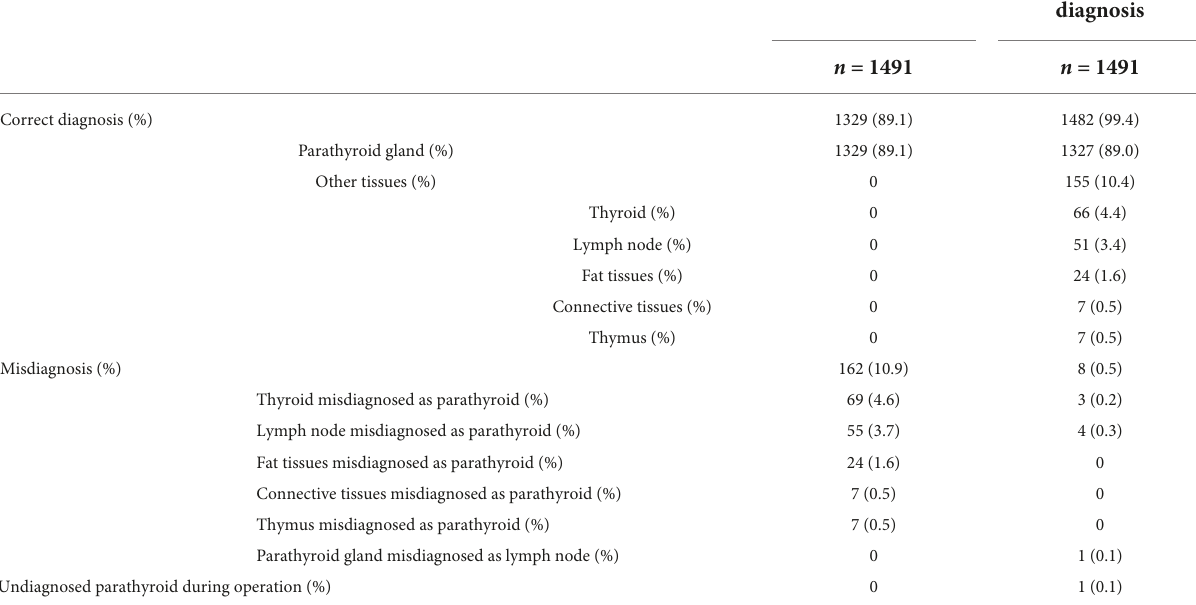
Surgeons’ diagnosis